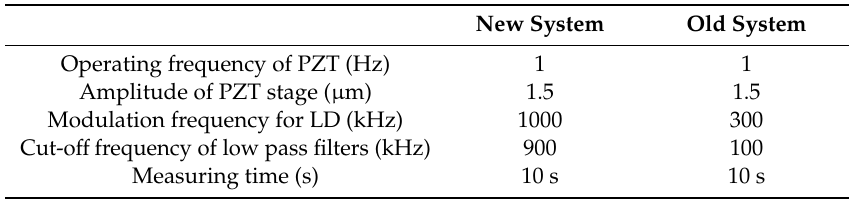
Figure 5. Frequency stability of the locked LD for 3 h.